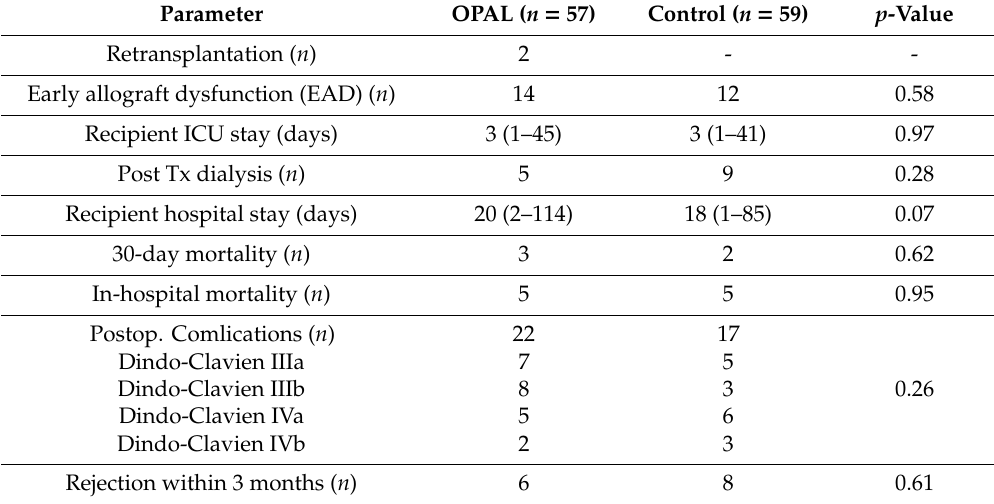
Table 2. Secondary outcome parameters: values given as median and range, where appropriate, in